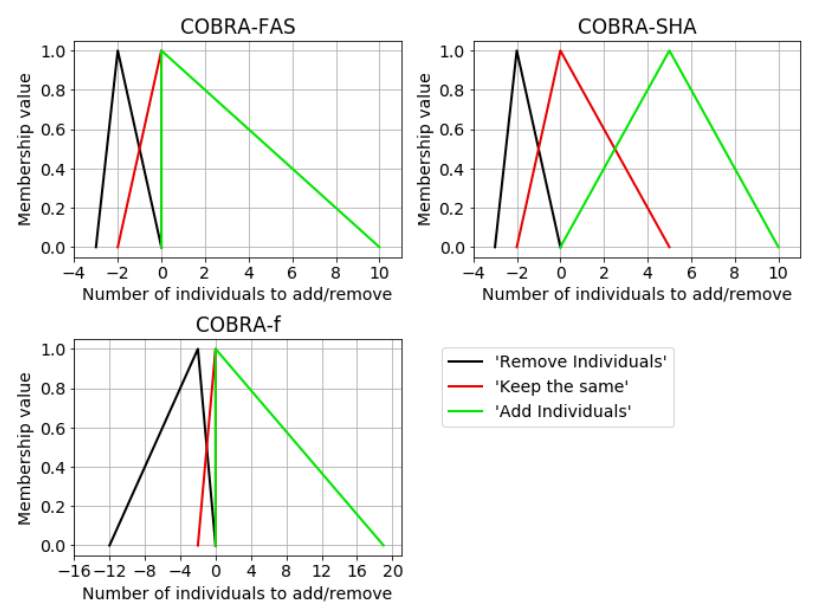
Figure 1. Fuzzy terms for all 6